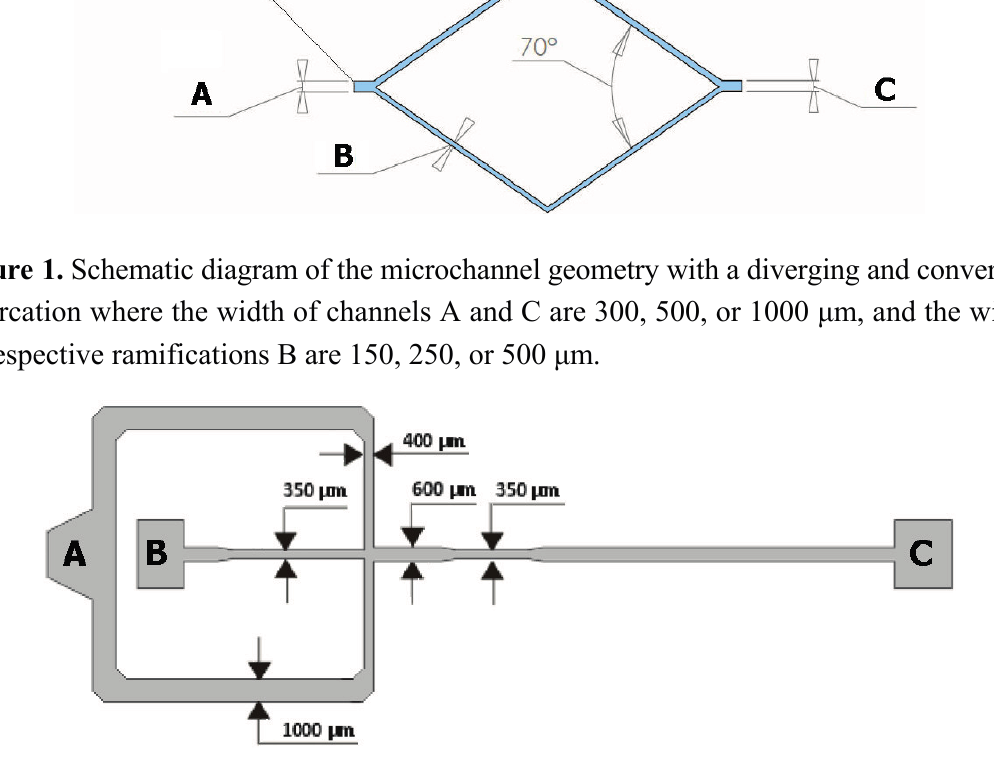
Figure 2. Schematic diagram of the microfluidic flow-focusing device geometry used to generate bubbles where continuous phase ( in vitro blood) and dispersed phase (air) are introduced in A and B, respectively, and C is the outlet of mixture of both